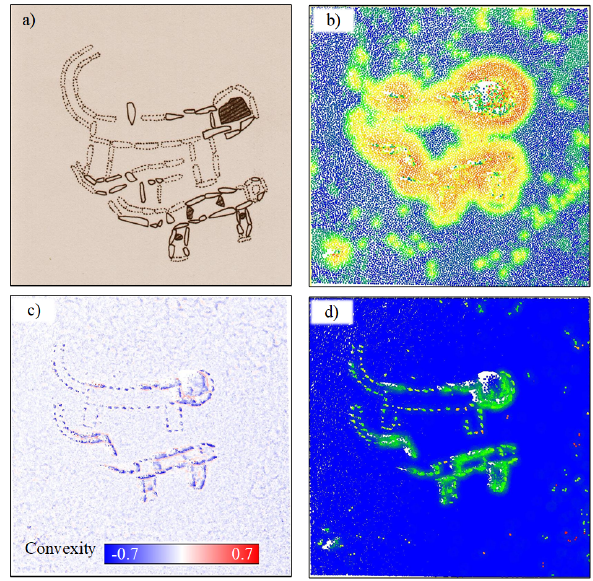
Figure 8. The Leopard Temple results: a) detail from Fig. (7);